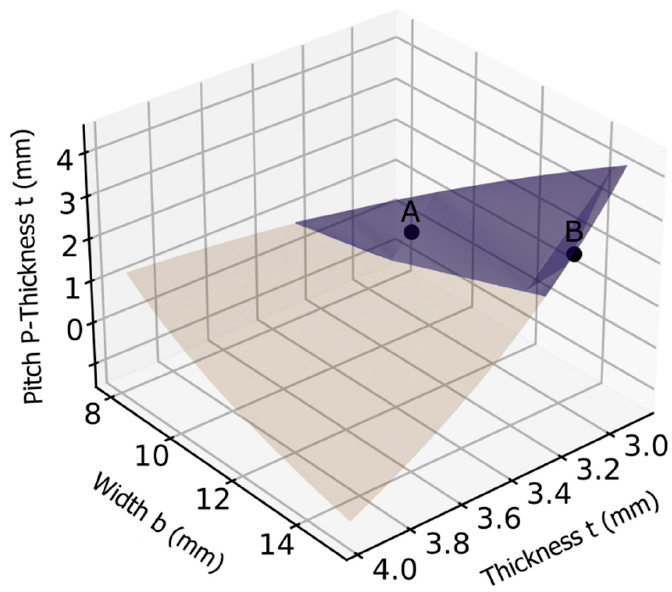
Figure 9. Parameter design for spring.